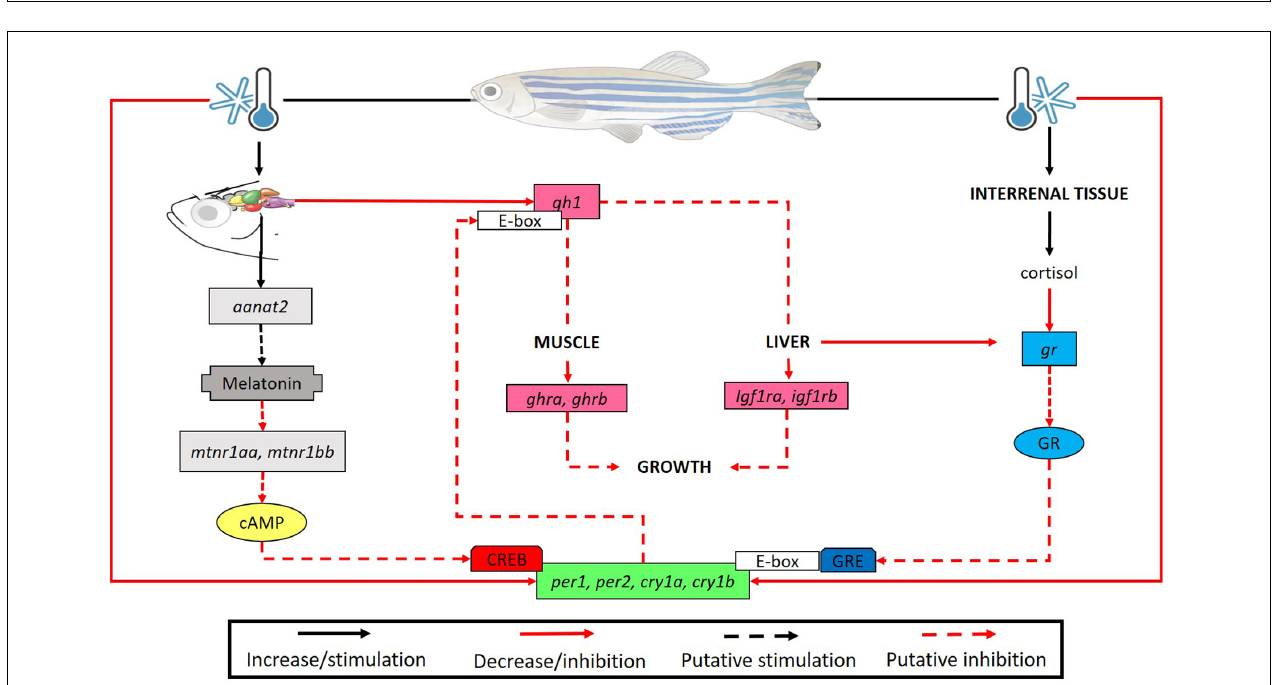
FIGURE 9 | Brain of D. rerio submitted to low temperatures show high levels of the aanat2 transcripts causing a putative increase in melatonin synthesis. We suggested that expression of melatonin receptors ( mtnr1aa and mtnr1bb ) may decrease to ensure homeostasis. In turn, it is known that mtnr1aa, mtnr1bb (Gi protein-coupled receptors) inhibit adenylate cyclase activity which ultimately leads to the inhibition of CREB phosphorylation, a transcription factor required for clock gene expression, resulting in a reduction of their transcripts. Also, in the brain we found a reduction in the gh1 transcripts at lower temperature, leading to a decrease of ghra and ghrb in the muscle, and igf1ra, igf1rb in the liver, suggesting a long-term inhibition of the animal growth. In turn, clock genes are capable to bind to the promoter E-box region of genes as gh1 thus modulating its expression (a putative inhibition in our study). On the other hand, there was an increase in the cortisol concentration and a compensatory reduction of its receptor transcripts. The glucocorticoid (Gc)/glucocorticoid receptor complex modulates the expression of clock genes by binding to glucocorticoid response elements (GRE) in their promoters. Consequently, we evidenced a decrease in the expression of clock genes in all organs analyzed. This may be associated to cold-modulation by melatonin and cortisol pathways or a direct effect of low temperature on clock gene transcripts.